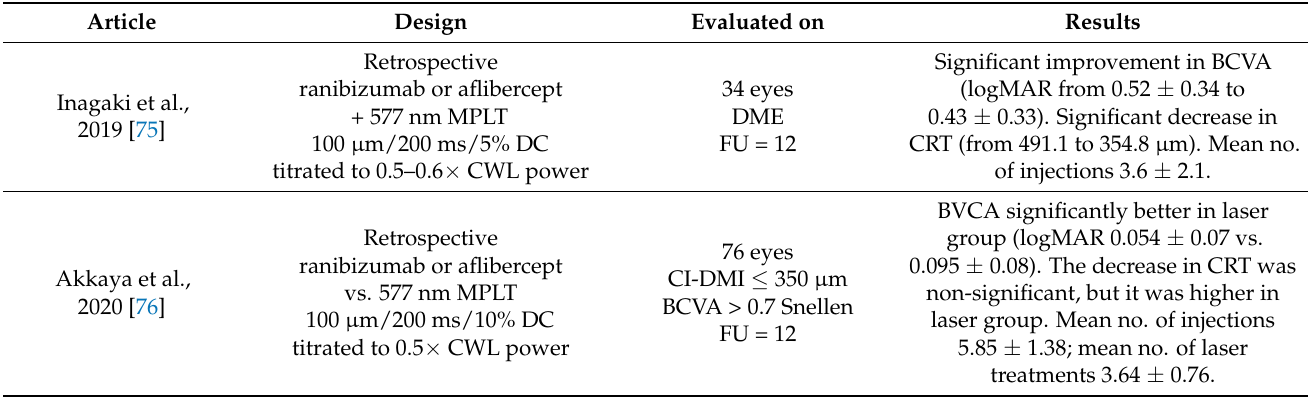
Table 5. MPLT and intravitreal